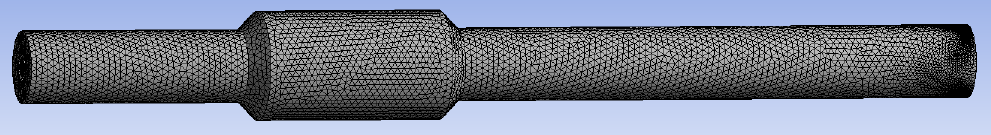
Figure 2. Schematic diagram of 45-degree angle expansion model in horizontal section.